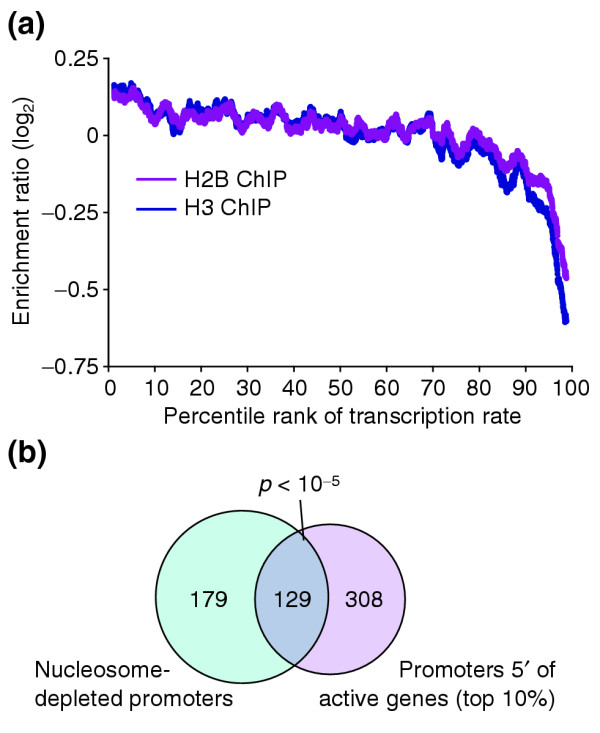
Inverse association between nucleosome occupancy and promoter strength. (a) Relative enrichment of promoter regions in the H3 and FLAG-H2B ChIP assays plotted against transcription rate of downstream genes (moving average, window 50). (b) Overlap between promoters upstream of active genes and the set of nucleosome-depleted promoters defined on the basis of depletion across the replicate H3 and FLAG-H2B experiments.